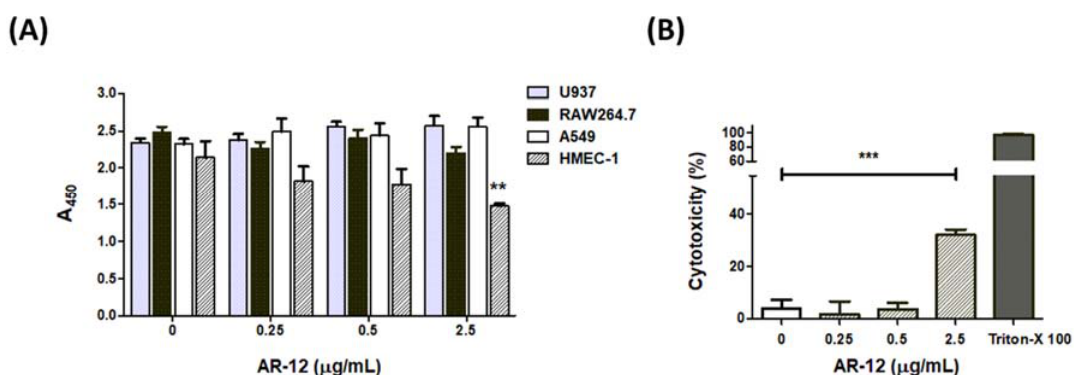
Figure 5. Cytotoxic analysis of AR-12. Cells were incubated with 0.25, 0.5, and 2.5 µ g/mL of AR-12 for 24 h: ( A ) The growth of A549, HMEC-1, RAW264.7, or U937 cell lines was determined by the WST-1 colorimetric assay. Absorbance was measured at 450 nm, and the results of three experiments are represented and expressed as the mean ± standard deviation; ( B ) the culture supernatants of HMEC-1 cells in the presence of different concentrations of AR-12 were collected at 24 h post treatment and then measured by the LDH detection kit. The cytotoxicity % was calculated, as described in the Materials and Methods Section. The results of the three experiments are represented and expressed as the mean ± standard deviation. Treatment groups were compared for significance using ANOVA. ** p < 0.01, *** p < 0.001 compared with the relative groups as shown in the figure.